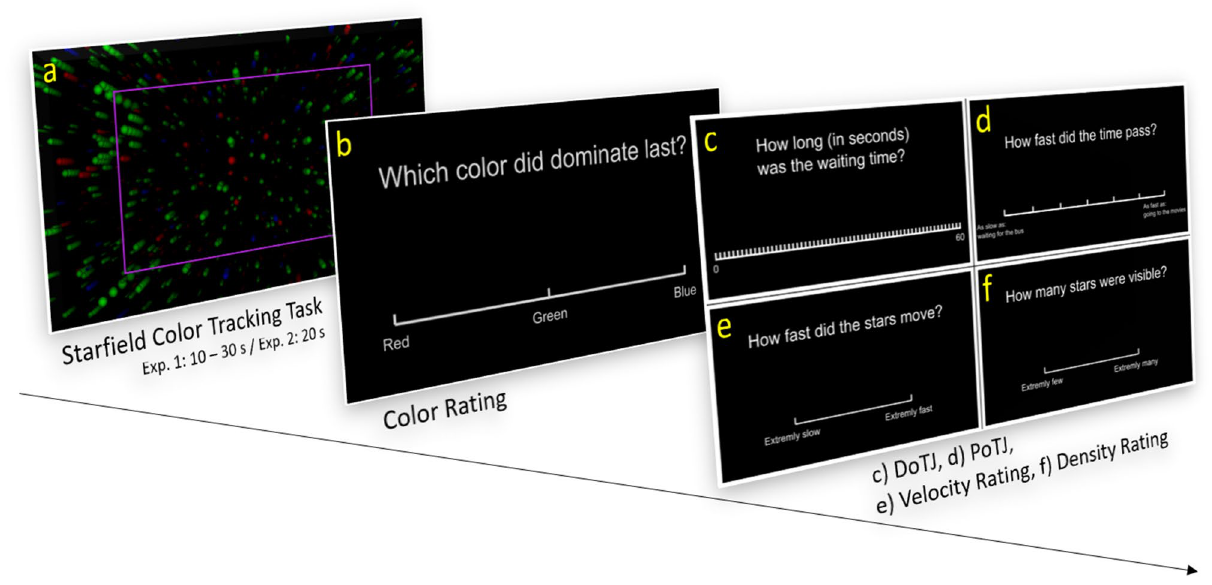
Figure 1. Schematic illustration of the trial course in Exp. 1, including the starfield ( a ), the screen for reporting the dominant color ( b ), and the screens for DoTJs ( c ), PoTJs ( d ), velocity ratings ( e ), and density ratings ( f ). Each trial started with the presentation of the starfield for 10, 20, or 30 s. Immediately afterwards, participants were then asked to report the dominant color, before being either asked to estimate the elapsed time ( c ), to rate the passage of time ( d ), to rate the velocity of the stars ( e ), or to rate the density of the starfield ( f ). The purple rectangle in the starfield screenshot ( a ) was not visible to participant but was added to illustrate the area in which stars would reappear after having reached the periphery of the screen. The course was the same in Exp. 2 but the displays for color reporting and PoTJs differed slightly. For additional information, see supplementary material